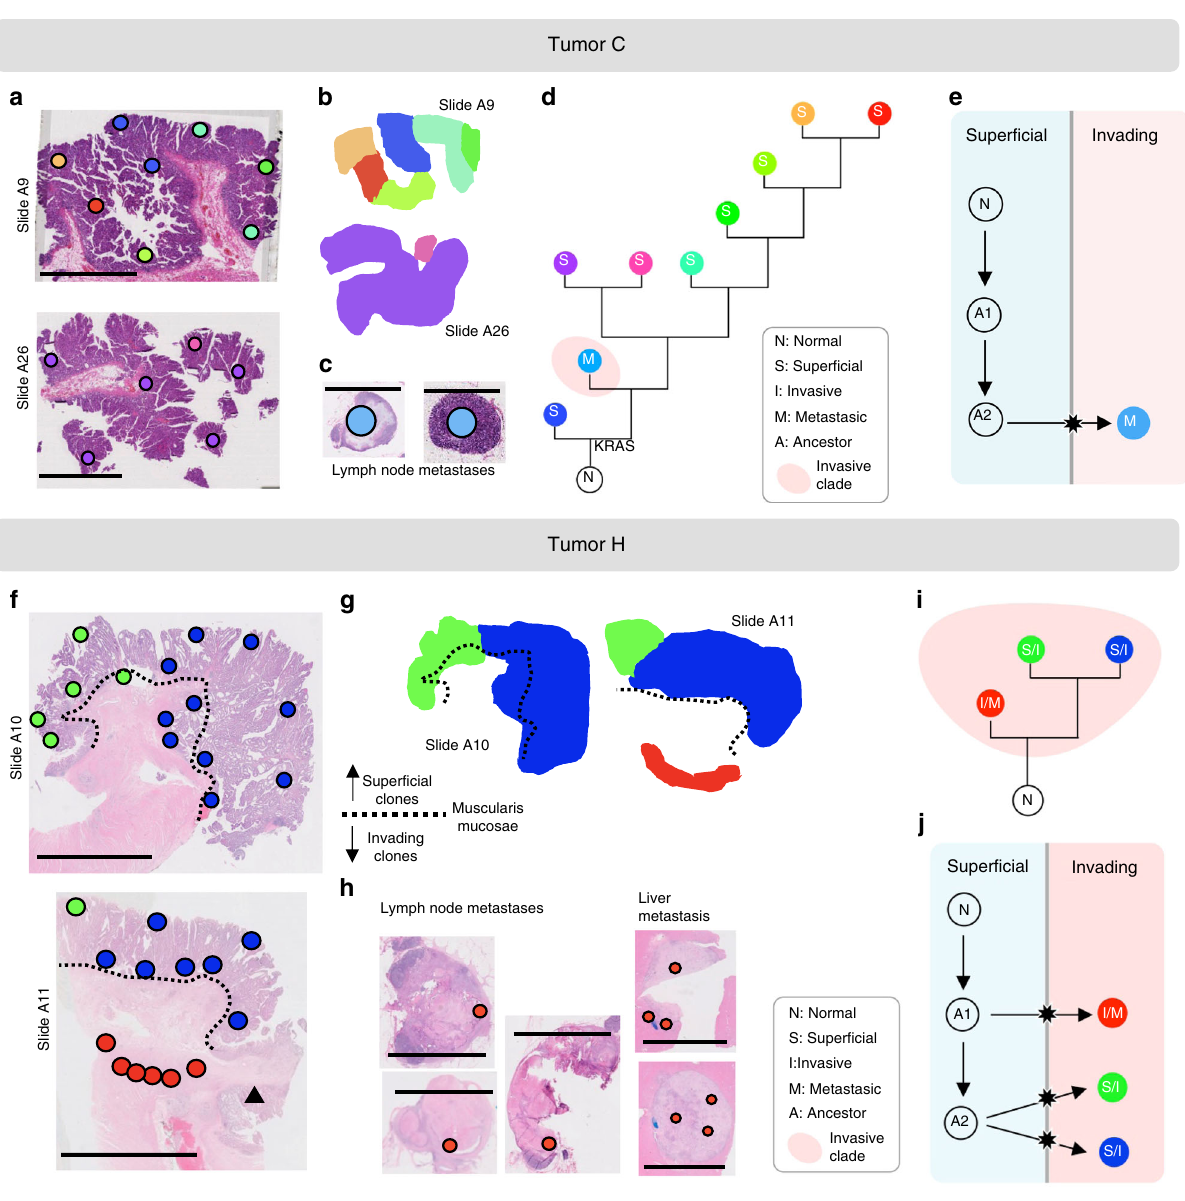
Fig. 4 Microscopic metastases and early branching in tumors C and H. a , f Spot genotypes were localized on the sections and sections annotated for super fi cial and invasive regions (scale bar: 1cm). In tumor, H, a deeply invasive ribbon of cells (red, slide A11) shared the genotype of the metastases, yet did not share the private mutations of the overlying super fi cial portions of the primary. b , g Contiguous clone maps were derived from the spot topographies. c , h Additional spots in the lymph nodes and liver metastases were microdissected (scale bar: 0.5 cm). d , i Maximum parsimony algorithms were used to reconstruct phylogenetic trees for the subclones. In tumor C, the two lymph node spots shared genotypes and branched early; the metastatic genotype was not found in the primary tumor. e , j The ancestry of invasive subclones was reconstructed under the assumption that cells migrate from super fi cial to invasive regions, but not vice